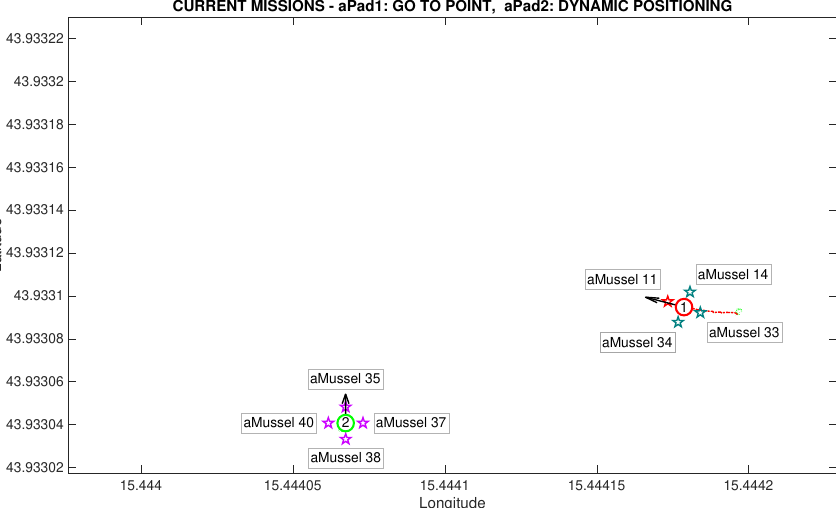
Figure 11. Initial deployment started in the Anoxia scenario experiment results from the deployment phase, reconstructed and replayed from recorded vehicle data—Biograd na Moru testbed.